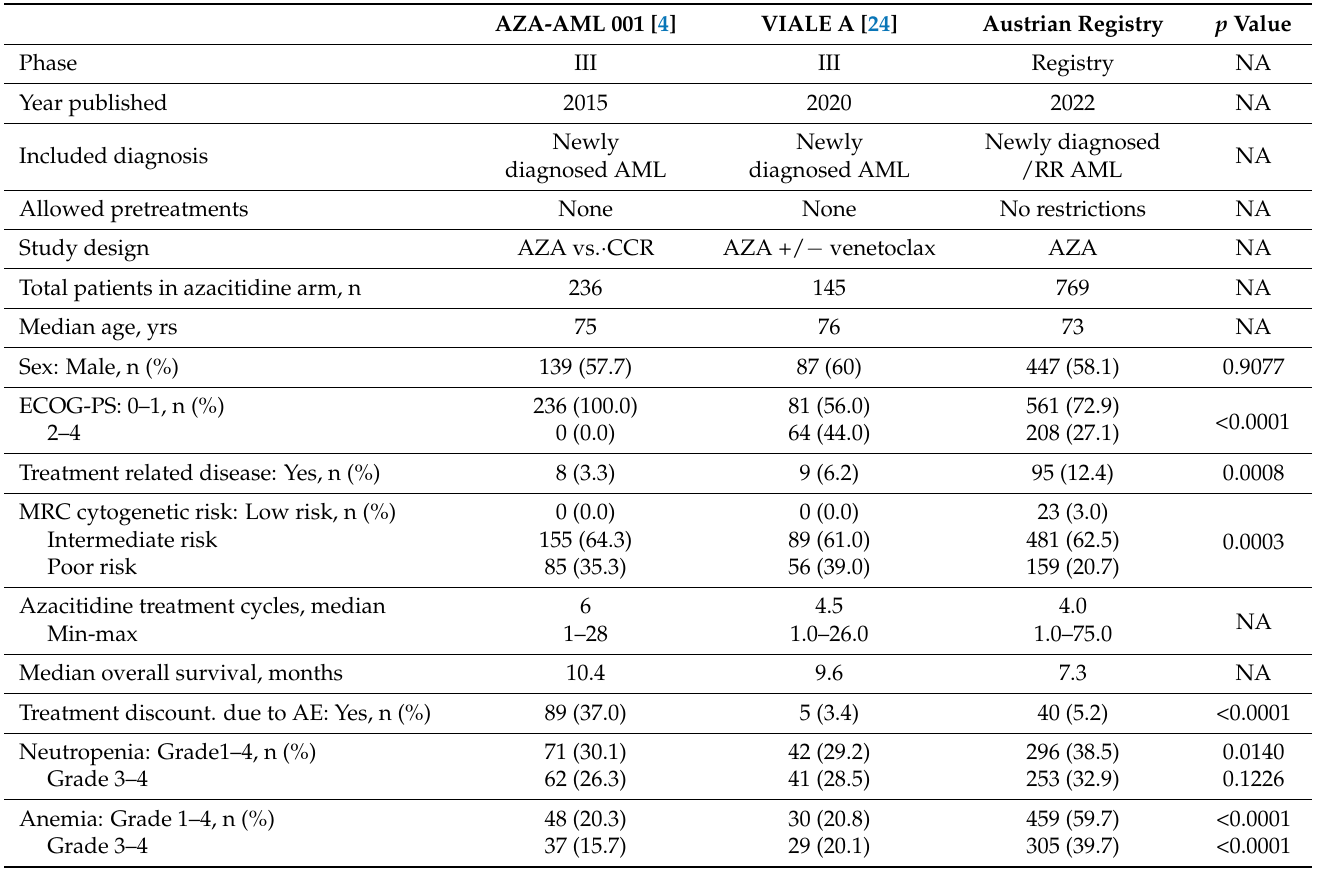
Table 4. Comparison of adverse events for patients with acute myeloid leukemia treated with azacitidine monotherapy within phase III clinical trials or the Austrian